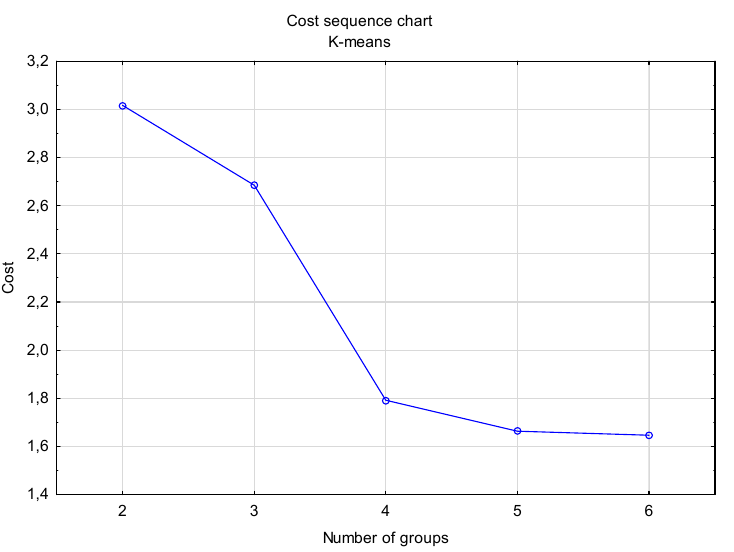
Figure 3. Cost sequence chart for k ‐ means classification for households of people aged 60 and older in 2018. Source: own elaboration based on data from [136].